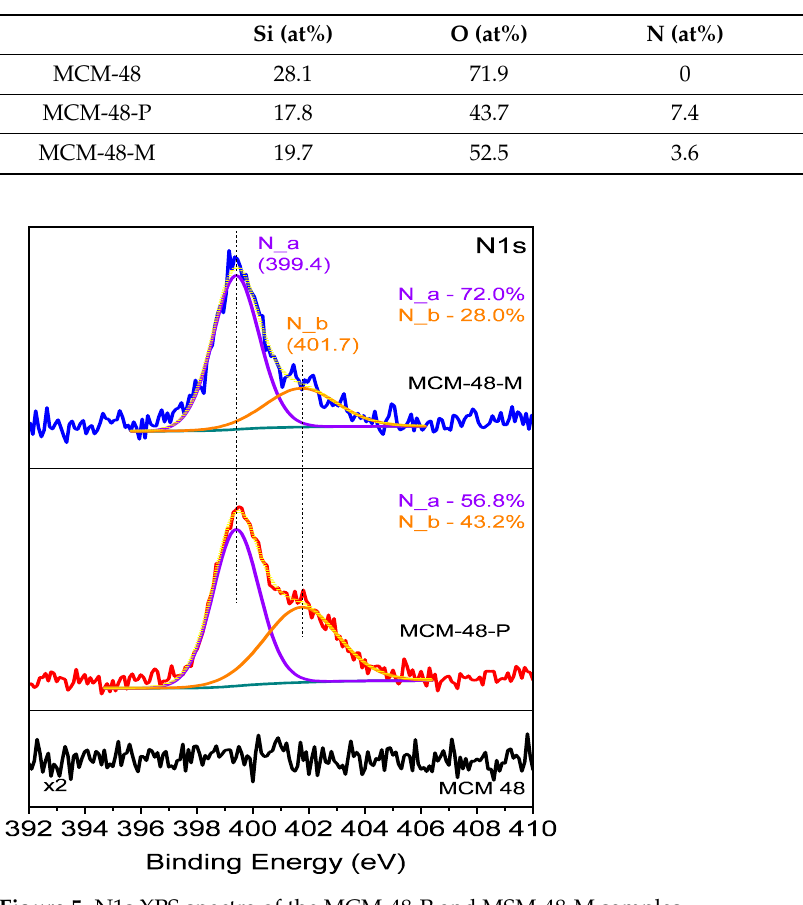
Figure 5. N1s XPS spectra of the MCM-48-p and MSM-48-M samples.